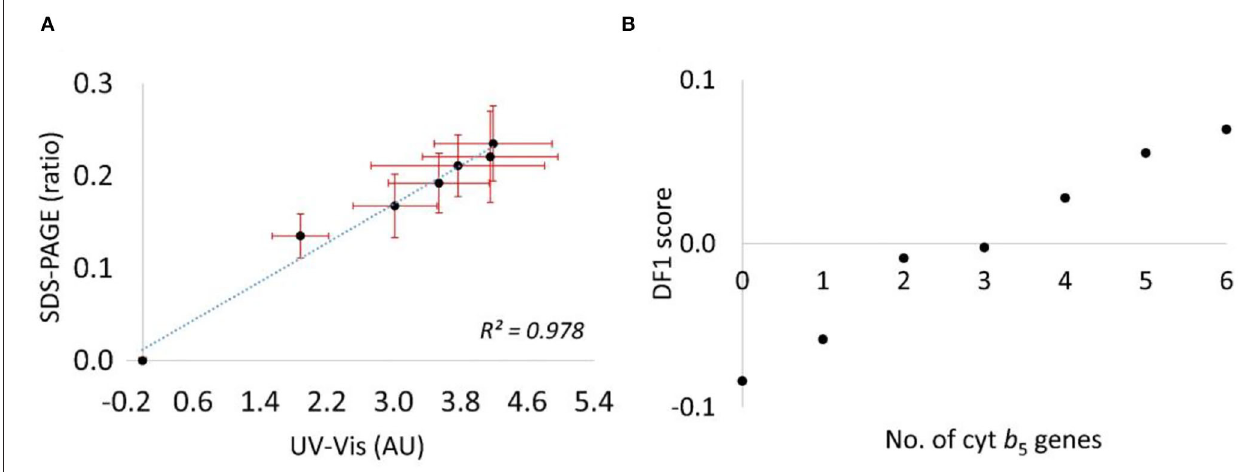
FIGURE 6 | (A) A combination plot of cyt b 5 content relatively quantified by the 2 techniques, the ratio of densitometric data from an SDS–PAGE (no unit) and colorimetric data from UV-vis absorption of a Soret peak (absorbance unit, AU). (B) A plot of DF1 score from the PC–DFA scores plot against numbers of cyt b 5